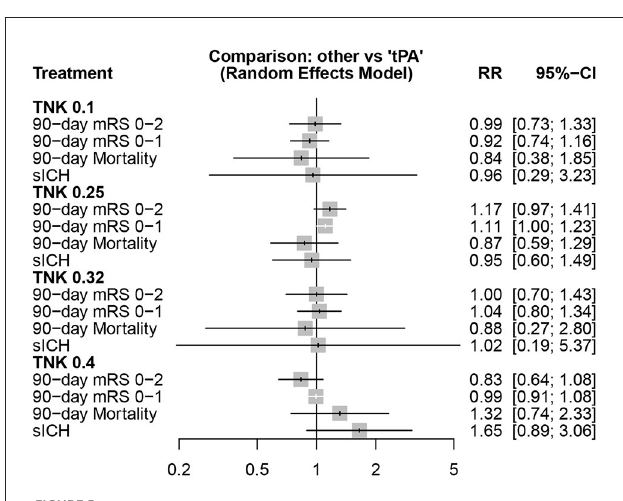
Different tenecteplase doses vs. alteplase